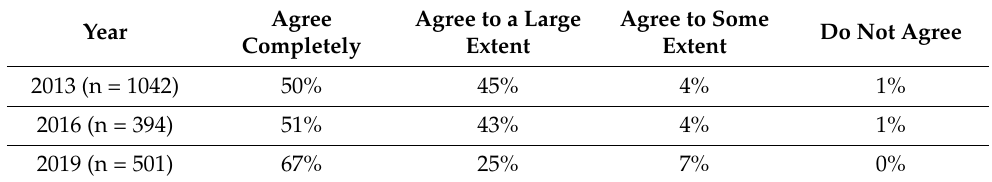
Table 4. Teacher responses to the statement ‘The test as a whole supports final grading’ (2013, 2016 and